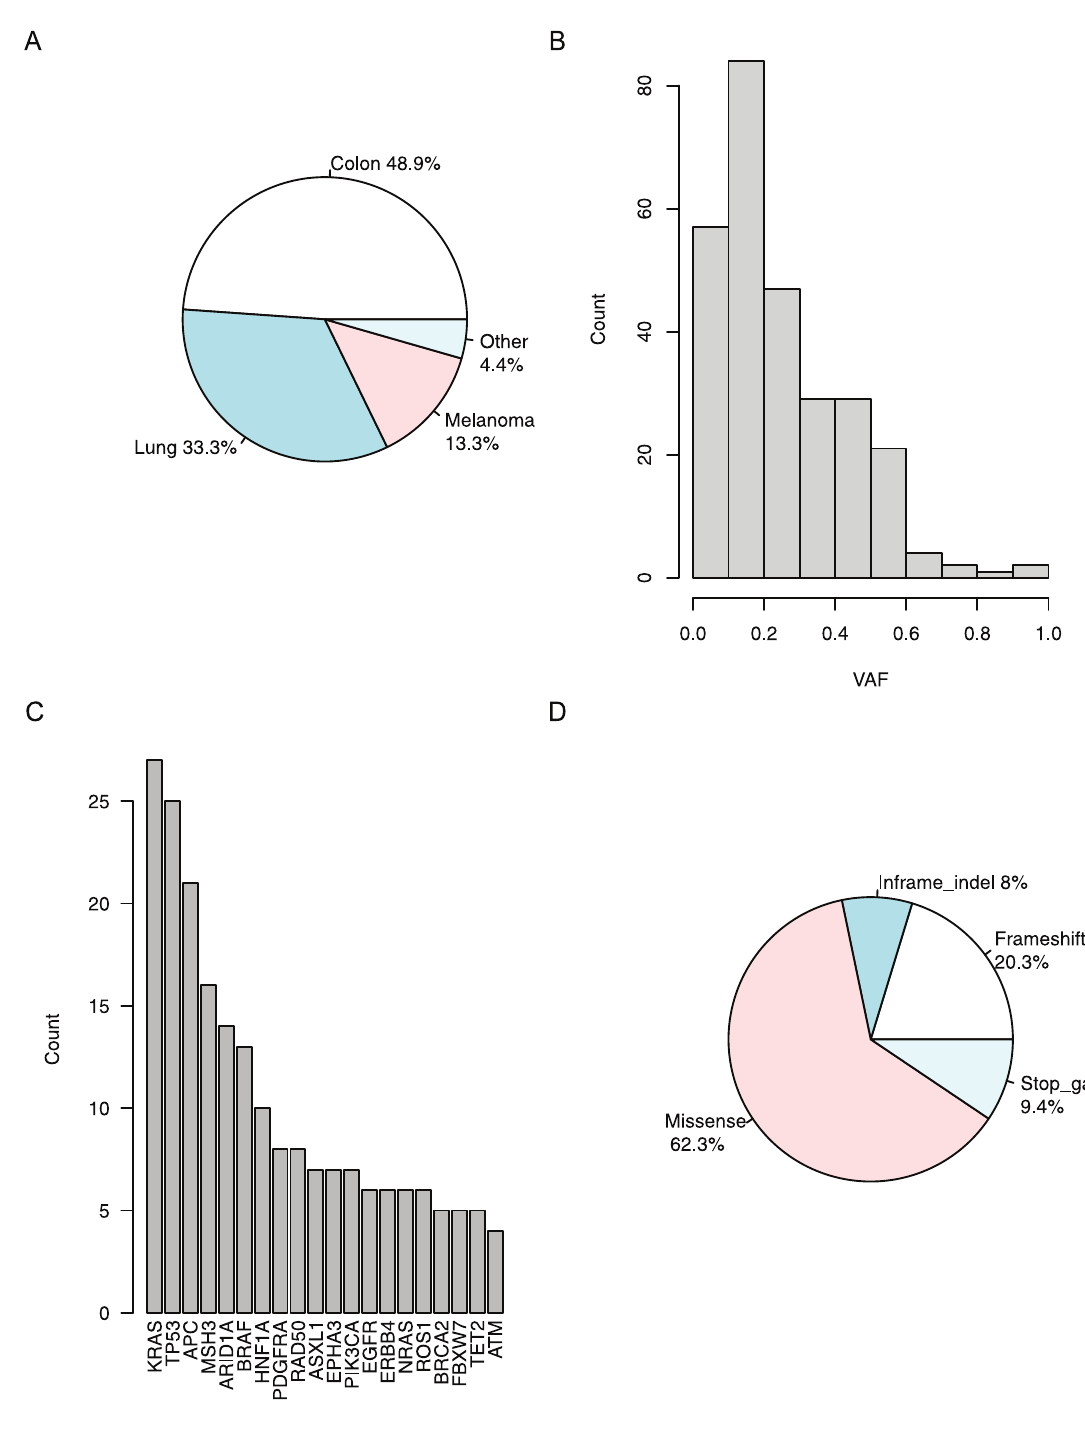
Fig 3. Clinical samples used in analytical validation. A) Source of clinical specimens, including 15 non-small cell lung cancer (Lung), 22 colorectal carcinoma (Colon), 6 melanoma, one gastric intestinal stromal tumor and one ovarian endometrioid carcinoma (Other). B) Distribution of the variant allele frequency of valid non-synonymous calls. C) Commonly mutated genes (top 20) in the cohort ranked by number of mutations as detected by ActSeq panel. D) Types of mutations in the cohort.